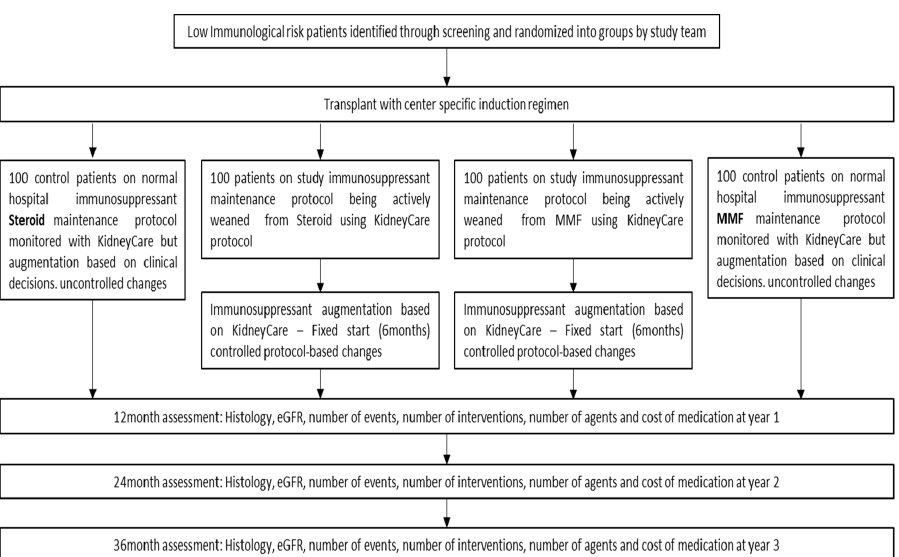
Figure 2. KIRA study design using multimodality testing to optimize immunosuppression.